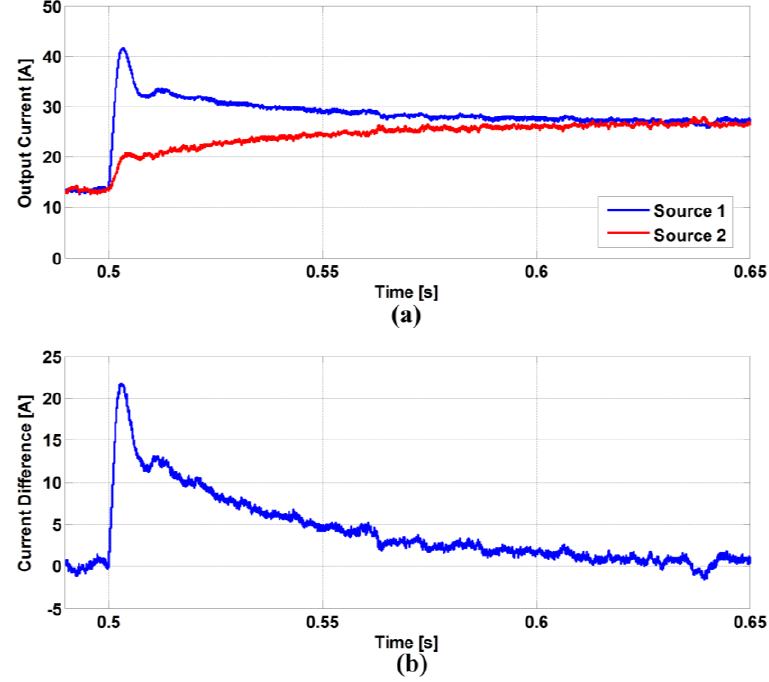
Figure 13. Simulated output current waveform ( L v 2 = 3 mH). ( a ): Output Current, ( b ): Difference.